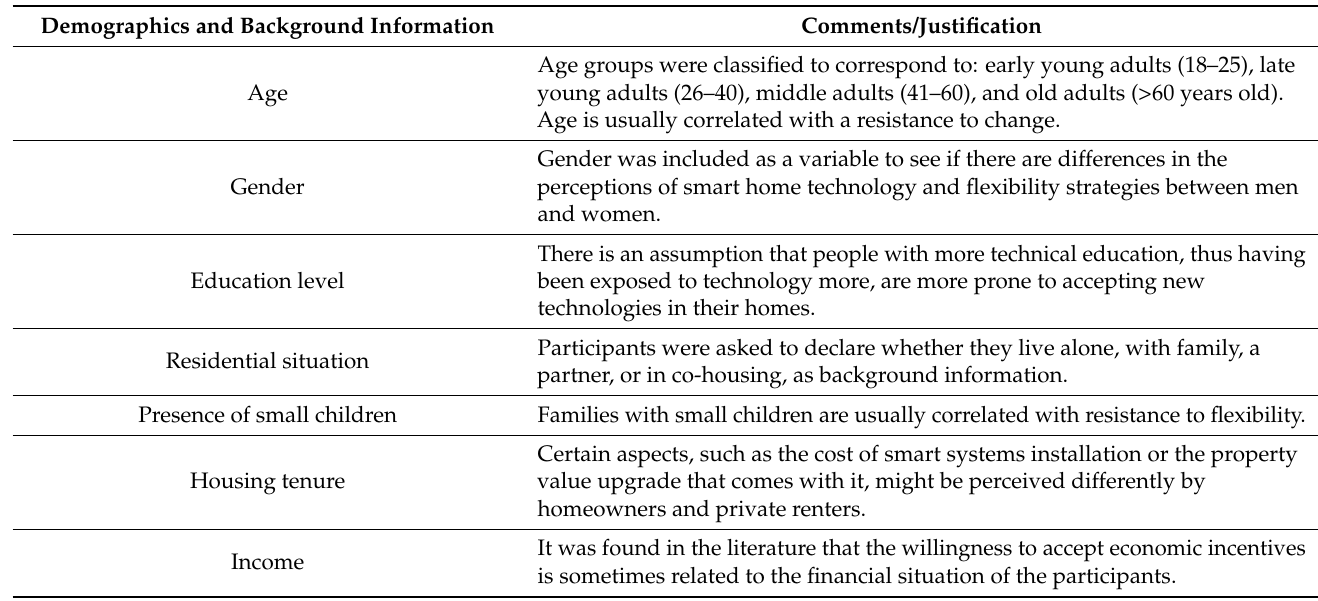
Table 2. Questionnaire—demographics and background section.